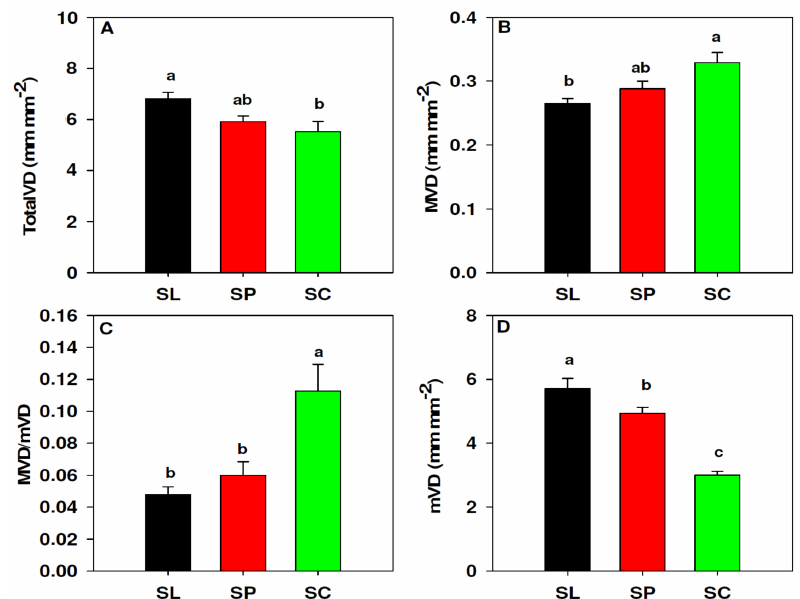
Figure 1. Differences in leaf venation between S. lycopersicum (black, SL), S. peruvianum (red, SP) and S. chilense (green, SC). Total vein density, TotalVD ( A ), major vein density, MVD ( B ), ratio of MVD to mVD, MVD/mVD ( C ), minor vein density, mVD ( D ). Values in ( A , B , D ) represent the mean and the error bars represent standard error. Values in ( C ) represent the median analyzed by Kruskal–Wallis analysis and error bars represent the 75% percentile. Different letters indicate significant differences ( p < 0.05) according to Fisher ( A , B , D ) and Dunn’s ( C )